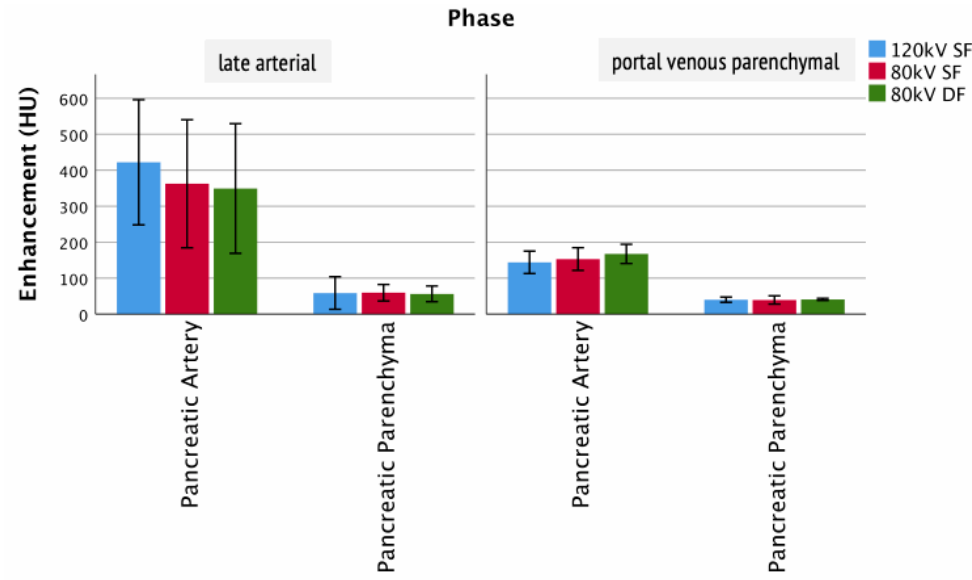
Figure 5. Enhancement of pancreatic structures. Columns show the enhancement of clinically rele- vant structures of the pancreas for the different injection protocols and clinically relevant phases.